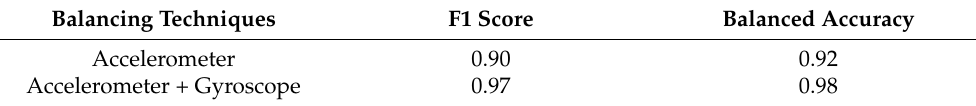
Table 4. Results for the different sensor types.